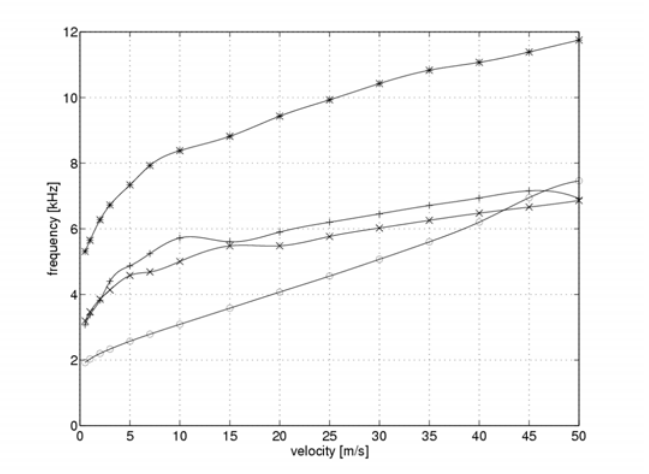
Figure 6. Frequencies during a full measurement cycle ("*" - optimal, "o" - minimum, "+" – intermediate, "x" – maximum gain value).